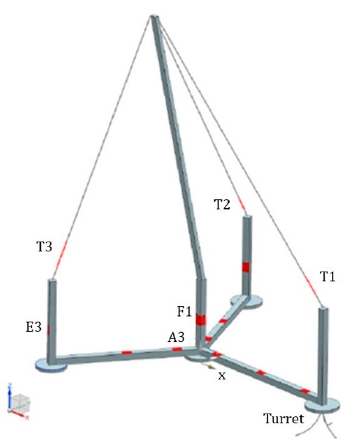
Figure 3. Location of the strain gauges and tension meters in the experimented model.